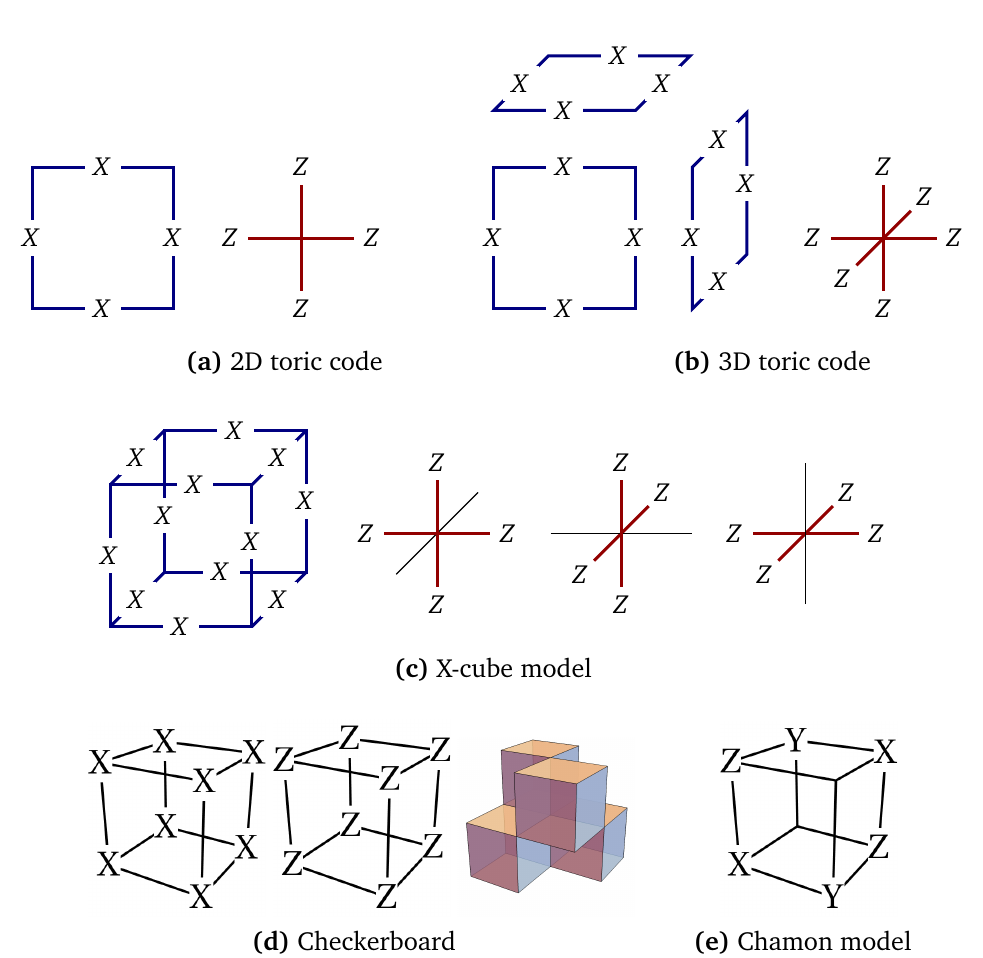
Figure 7: Hamiltonian terms for the stabilizer code models